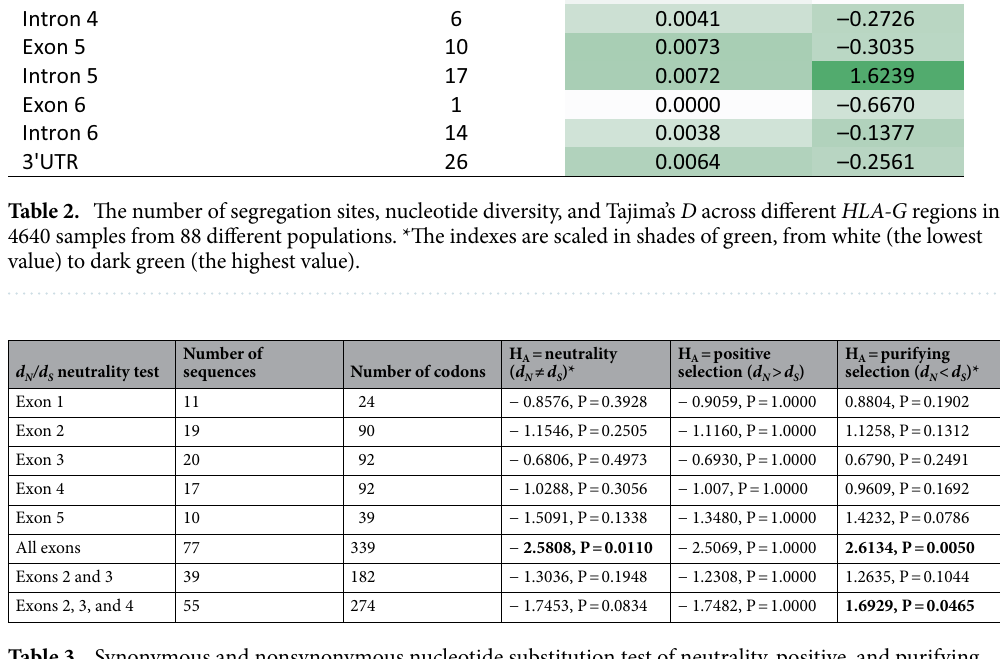
Table 3. Synonymous and nonsynonymous nucleotide substitution test of neutrality, positive, and purifying selection for analysis over 77 HLA-G sequences defined by exon mutations, in 4640 samples from 88 different populations. *Significant P -values are marked in